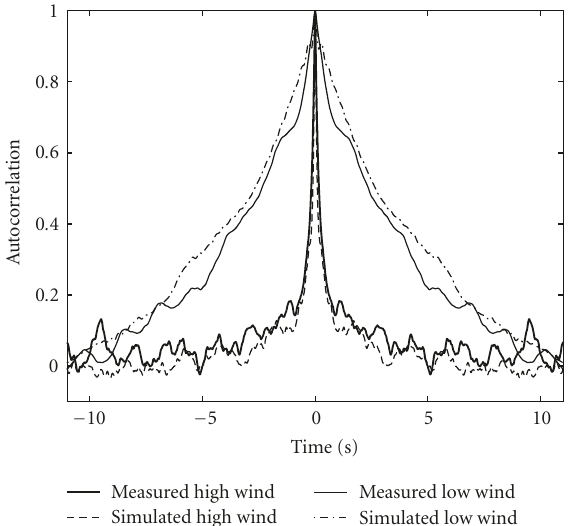
Figure 14: AFDs of measured (dry leaved deciduous trees (Site 1)) and simulated (using the new model) signals at 29GHz during low ( w m = 2m/s) and high ( w m = 5m/s) wind speed conditions. All simulation parameters are given in Table 3.